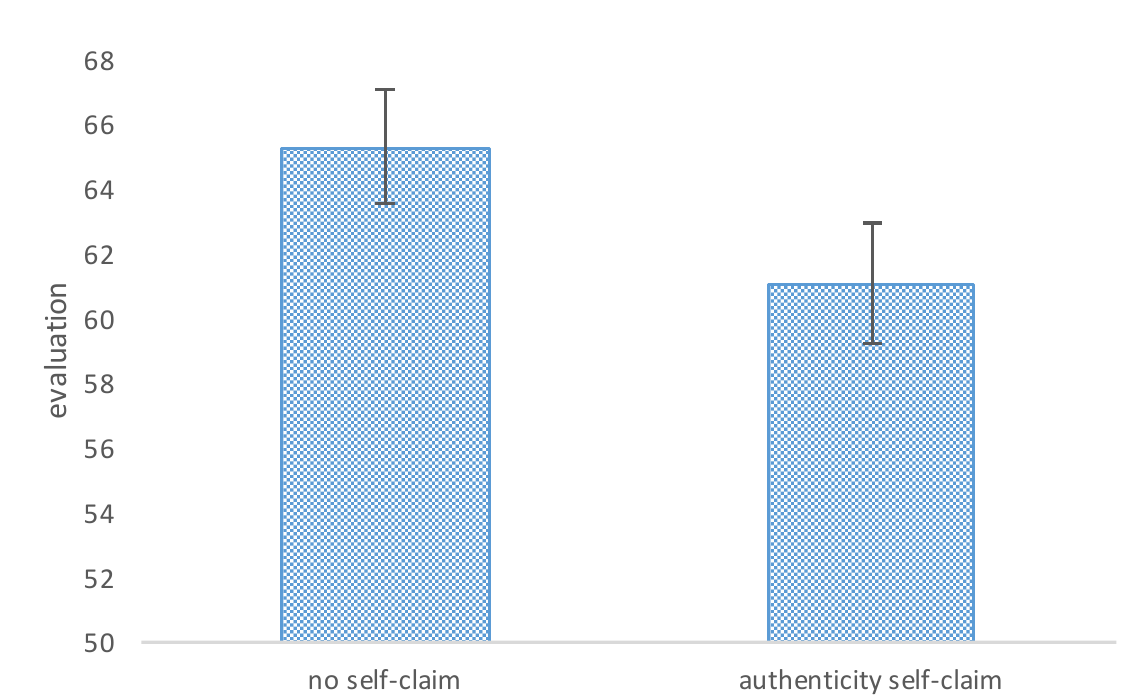
Figure 4: Mean responses to no self-claims versus authenticity self-claims (study 2). N = 287, p <